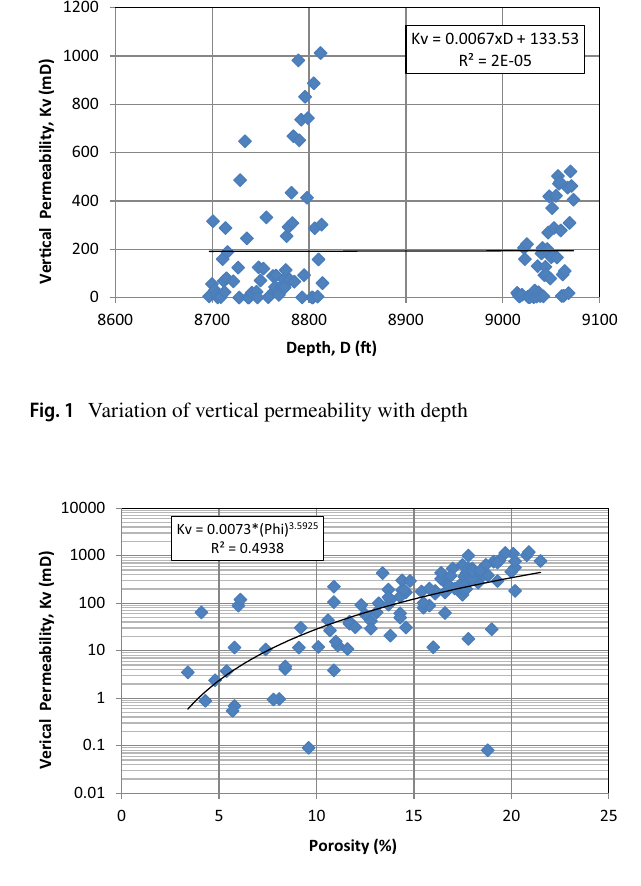
Fig. 2 Vertical permeability and porosity relationship